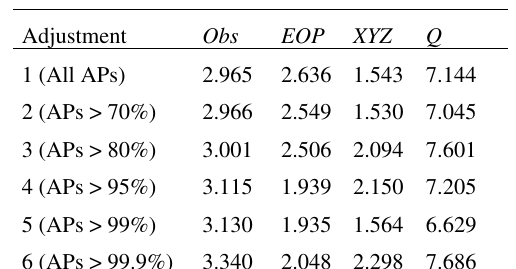
Table 4. Percentage of improvement associated to each check point in its respective scan for the Leica HDS 3000.